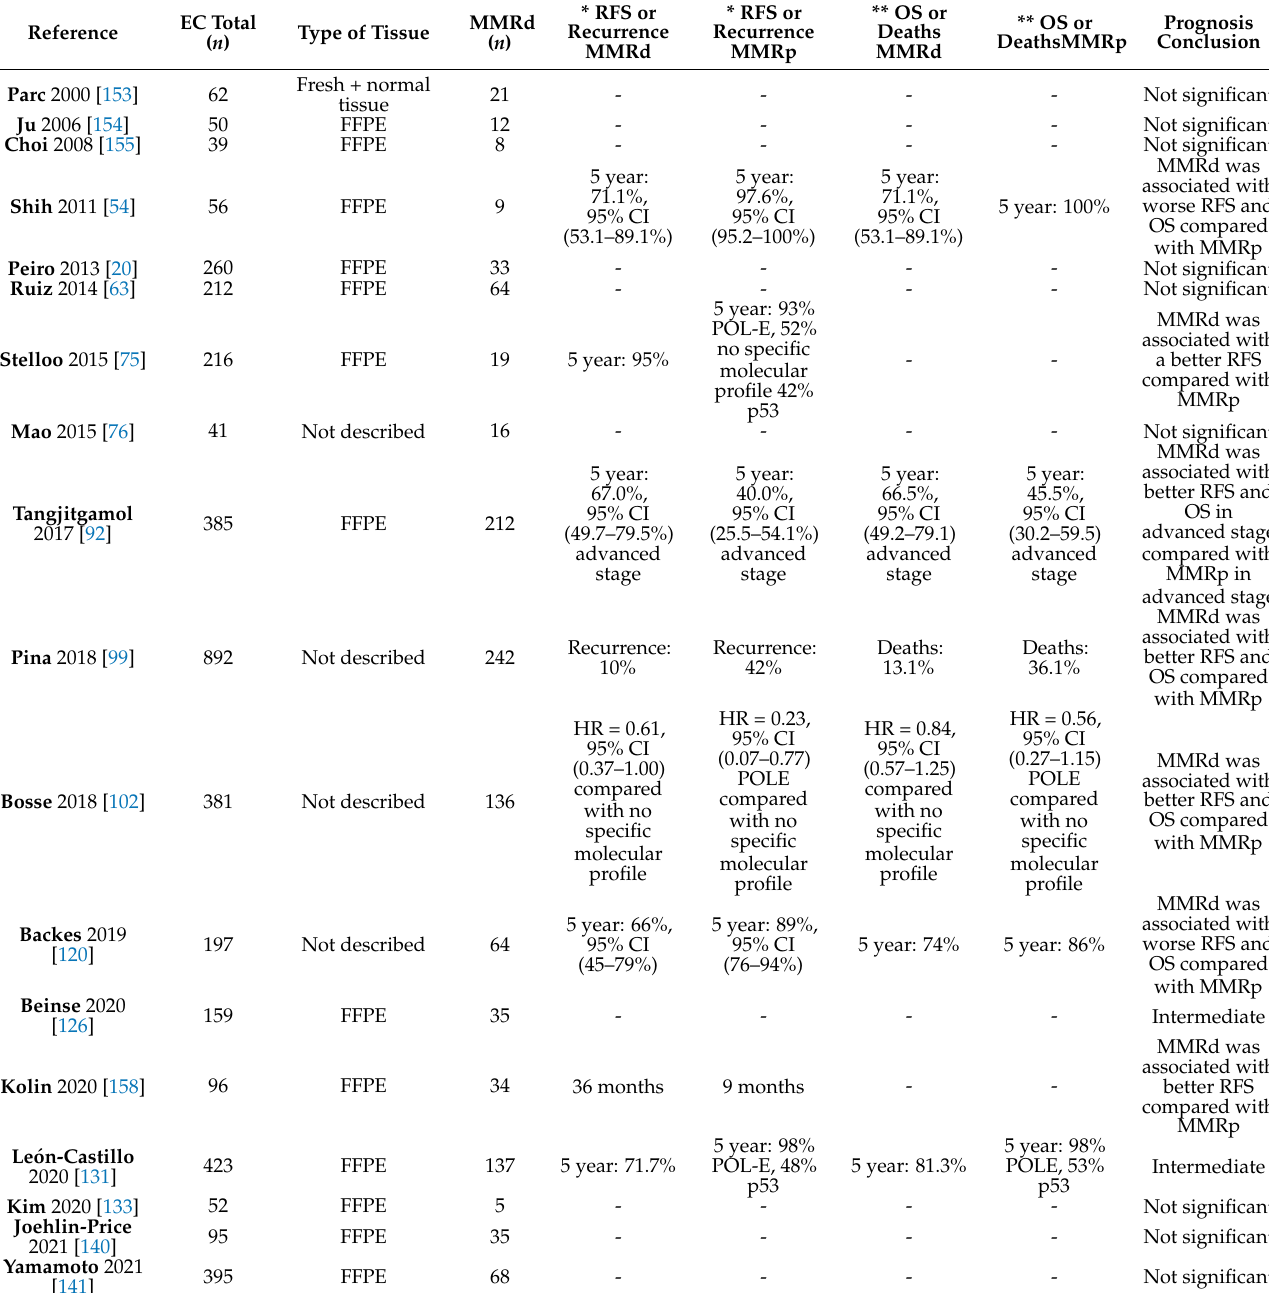
Table 5. Prognosis of MMRd tumors compared with MMRp tumors in